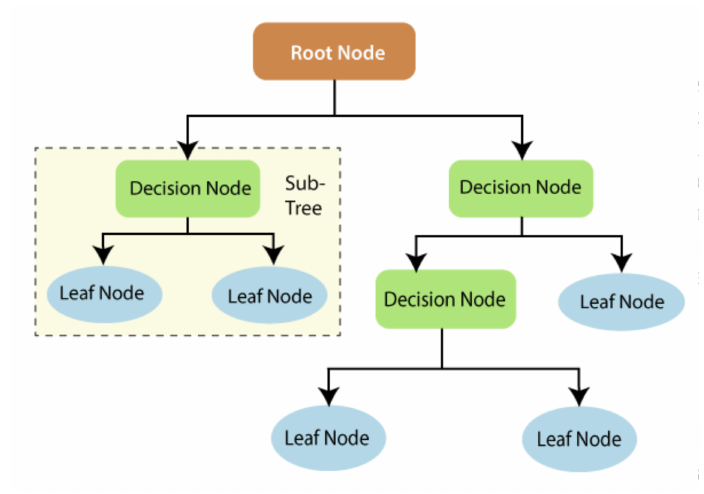
Figure 4. Overall description of